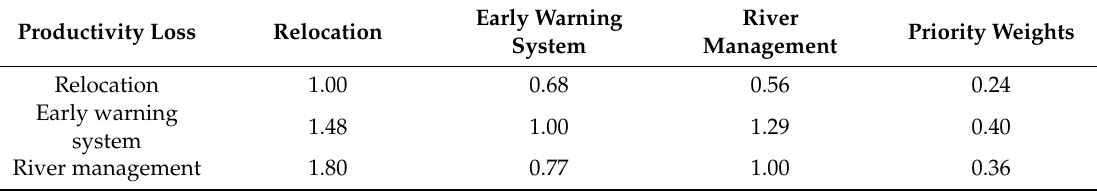
Table A3. Judgment matrix with respect to productivity loss